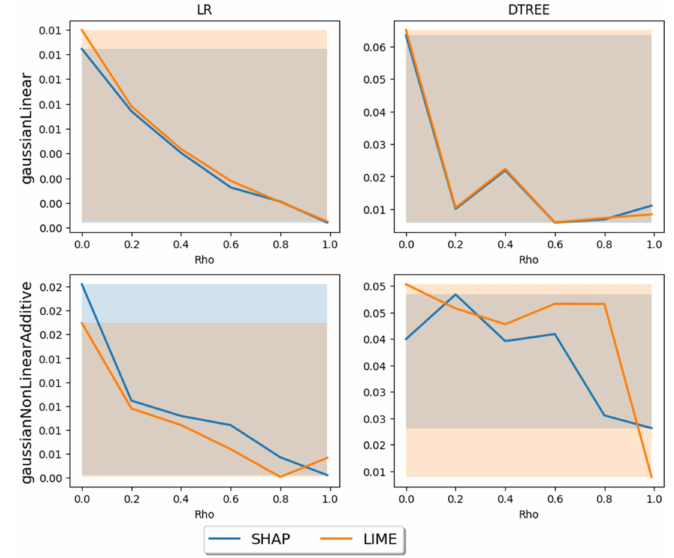
Figure 6. The incompleteness